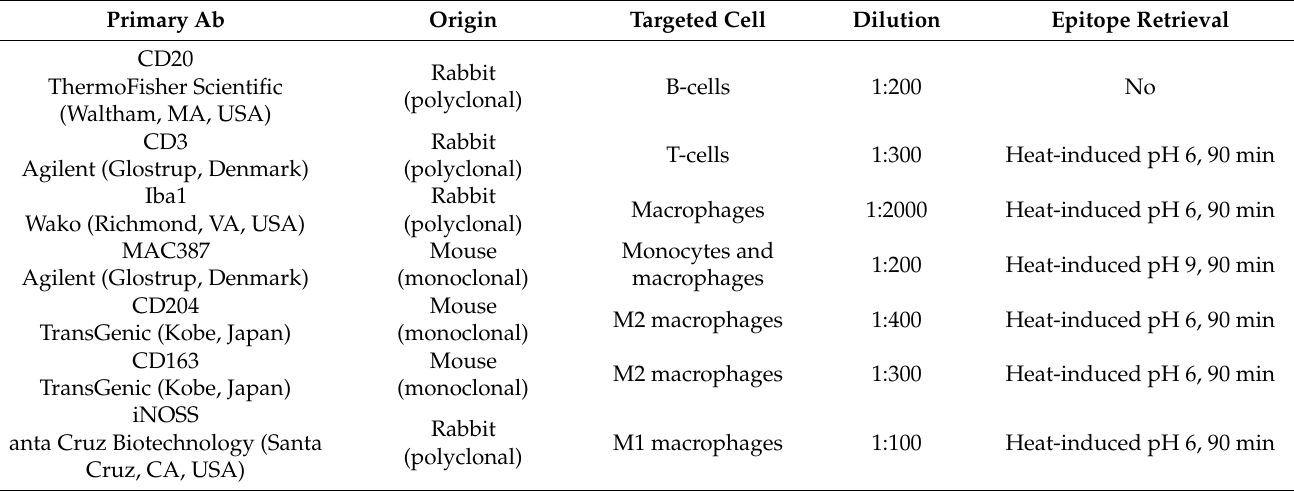
Table 1. Primary antibodies used in the